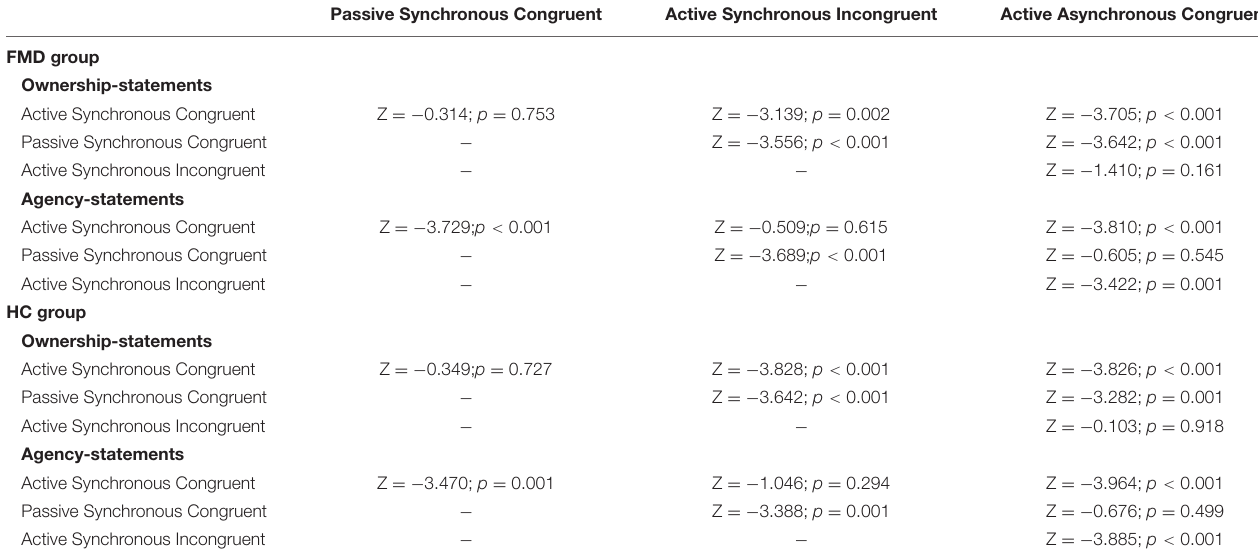
TABLE 4 | Wilcoxon signed-rank comparisons between conditions for ownership and agency statements in each